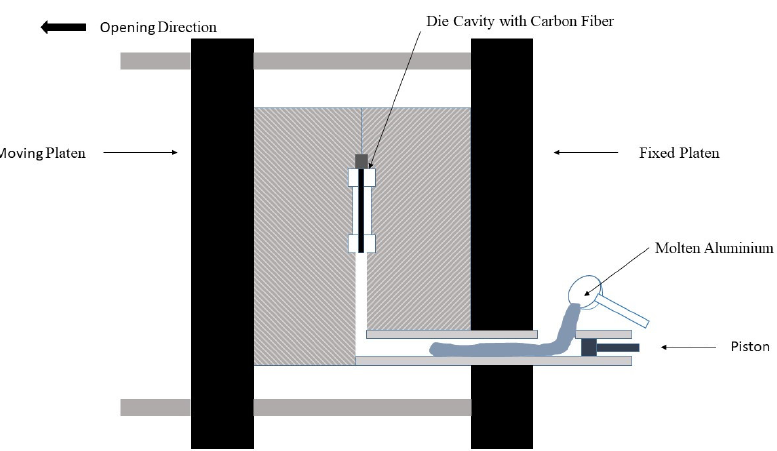
Figure 1. Scheme of the high-pressure die casting process. Two types of carbon fiber preforms were used: unidirectional carbon fibers (UD); and